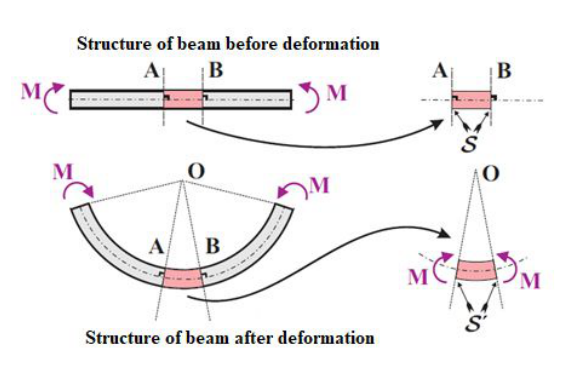
Figure 1: Structure of beam with before and after deformation